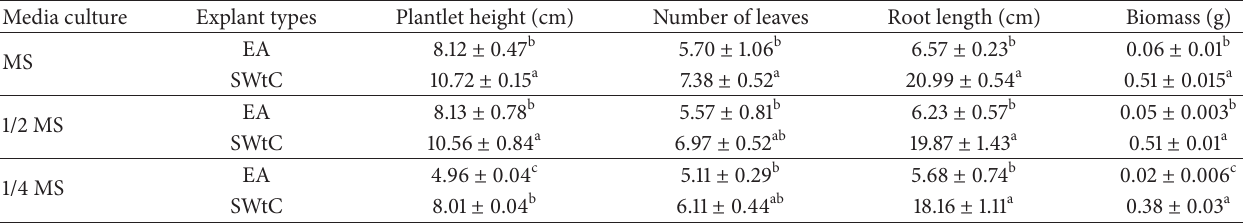
Table 2: Growth performance of Bambara groundnut in vitro plantlets derived from two explant types on different strengths of MS basal medium after four weeks of cultivation.